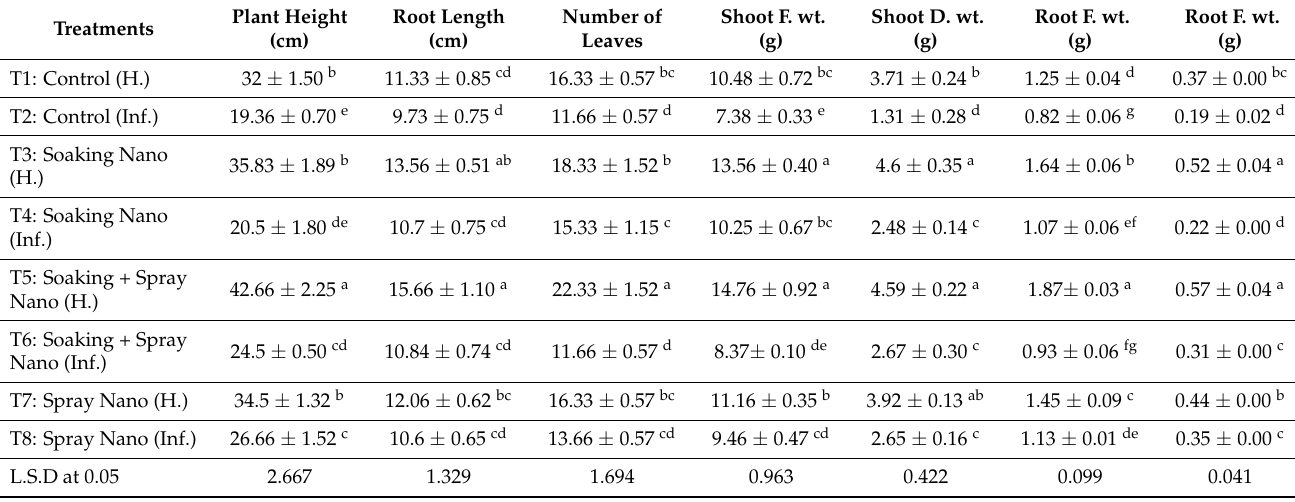
Table 3. Effect of biogenic Se-NPs on morphological indicators of Vicia faba L . under pot conditions.